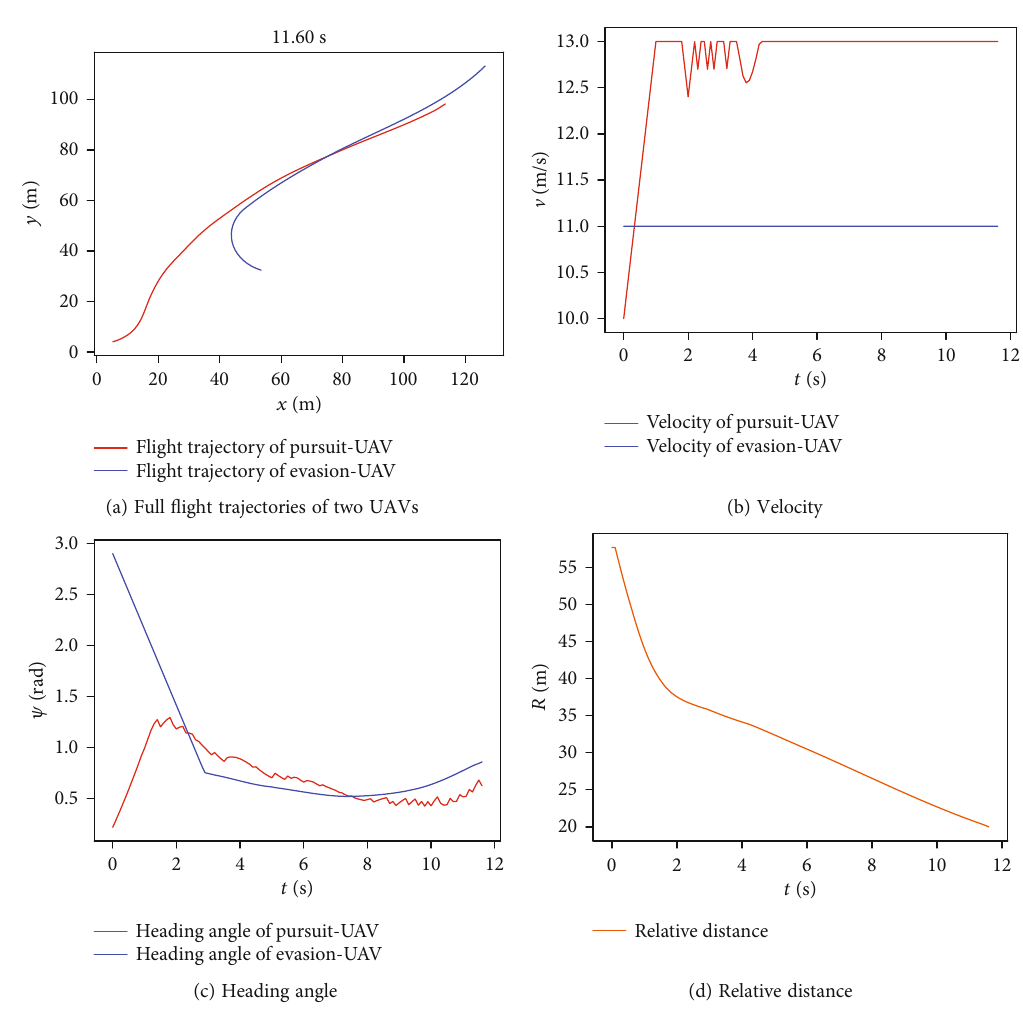
Figure 14: Flight trajectories and test results using